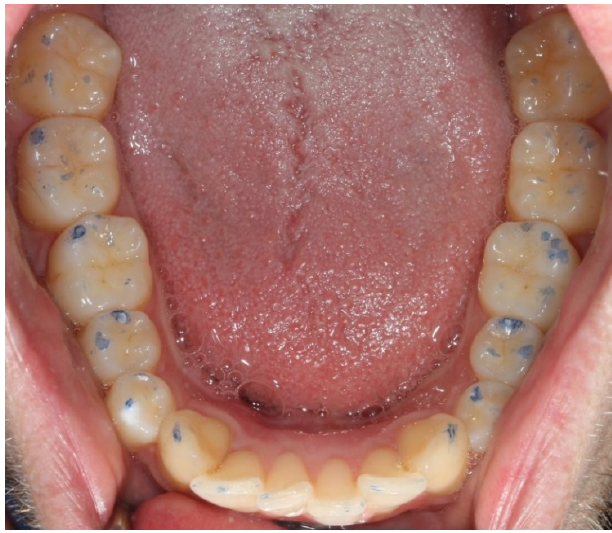
Figure 1. Lower jaw in the clinical examination. The number of occlusal contacts on each tooth was registered for both jaws. Third molars were not registered (only 4 of the 29 participants had third molars). The number of actual occlusal contacts on each tooth was registered by authors JS and SN, who performed one registration